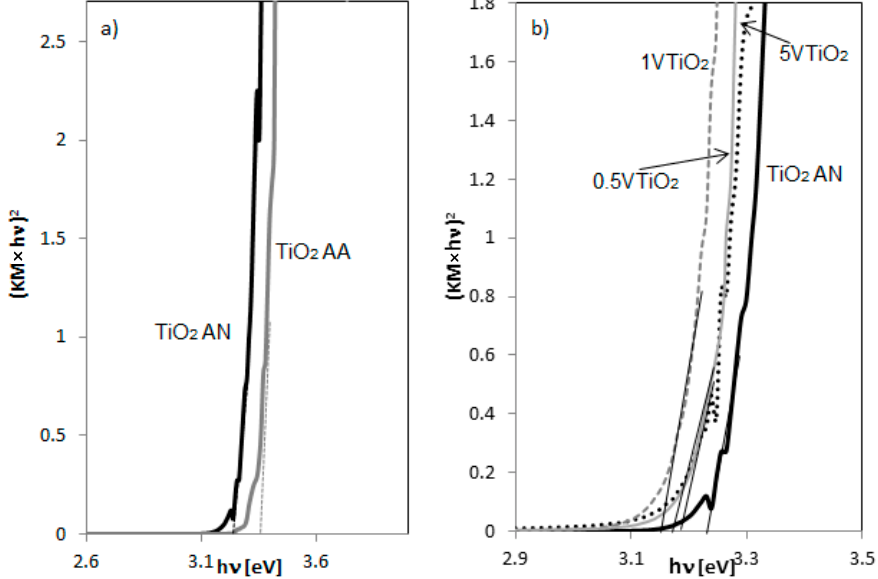
Figure 3. Elaborations of UV–Vis Diffuse Reflectance Spectra for ( a ) TiO 2 AA and TiO 2 AN; ( b ) TiO 2 AN, 0.5VTiO 2 , 1VTiO 2 and 5VTiO 2 .